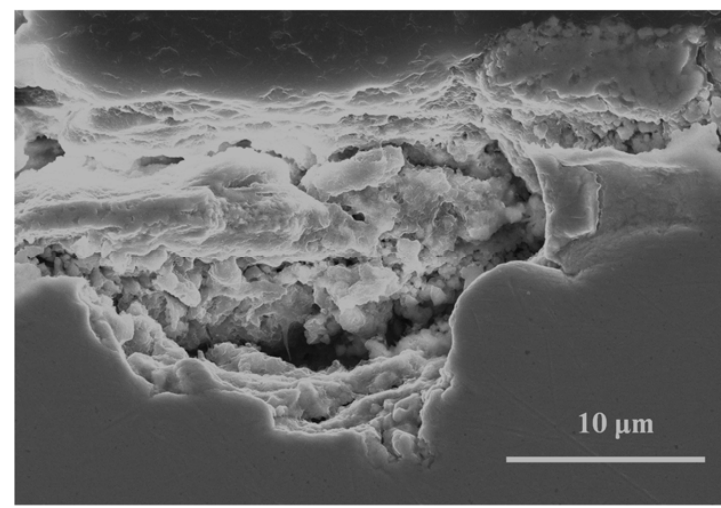
Figure 9. Pitting of the copper substrate when exposed to the marine atmosphere with a high chloride deposition rate.